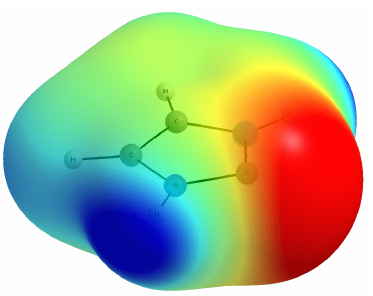
Figure 3. Map of the electrostatic potential (in a.u.) of imidazol-2-ylidene: − 0.06, red; − 0.03, yellow; 0.00, green; 0.03, cyan; 0.06,